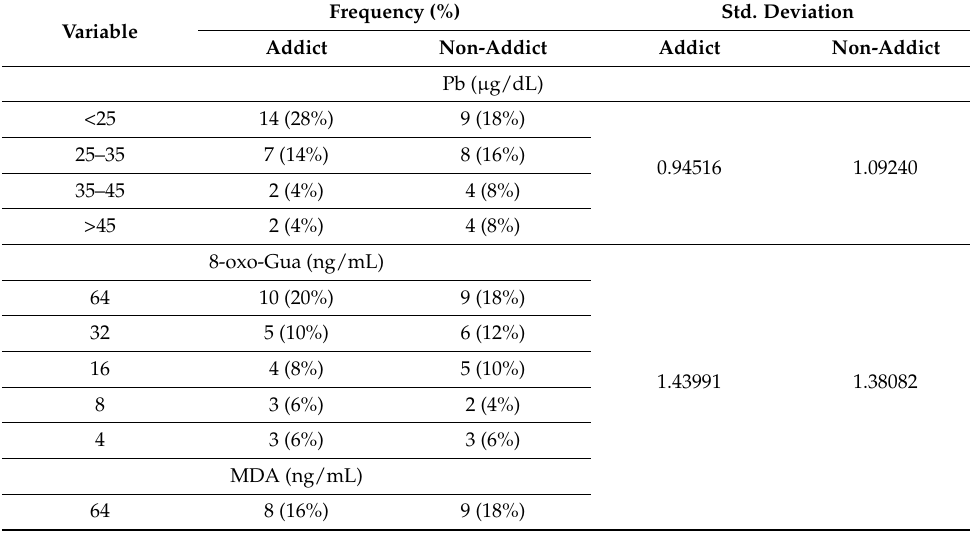
Table 2. The frequency of blood Pb, 8-oxo-Gua, and MDA levels in addict and non-addict